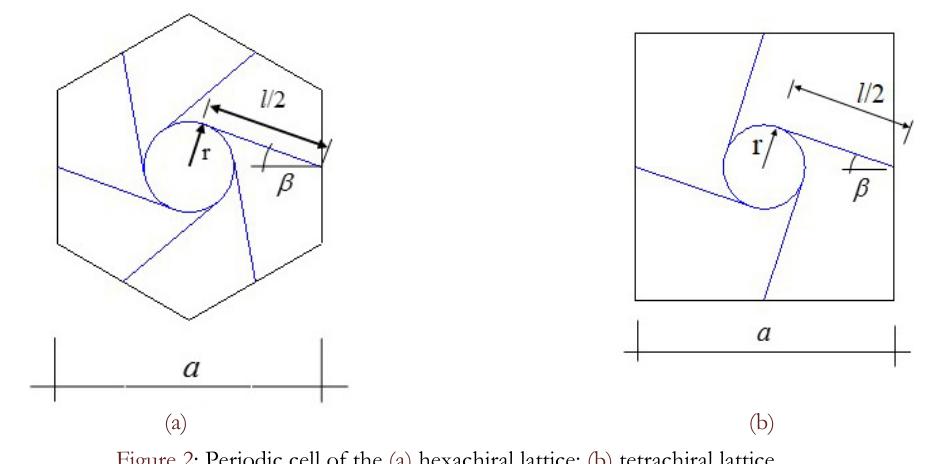
Figure 2: Periodic cell of the (a) hexachiral lattice; (b) tetrachiral lattice.